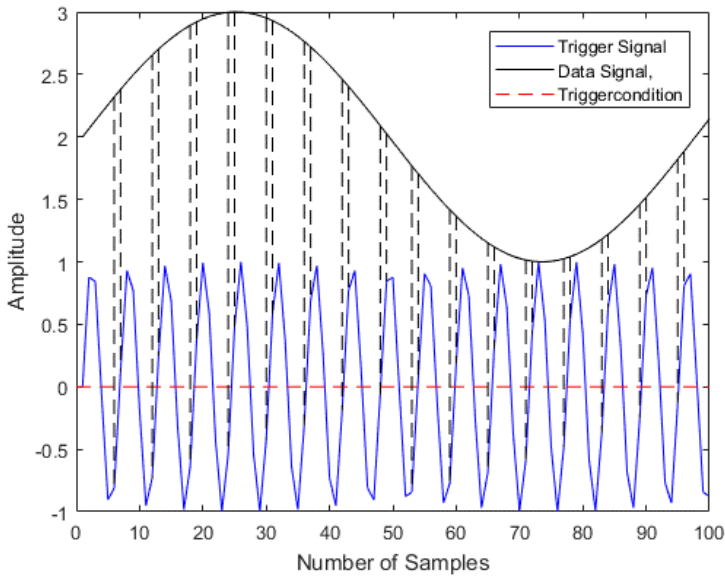
Figure 1. Trigger acquisition schematic.